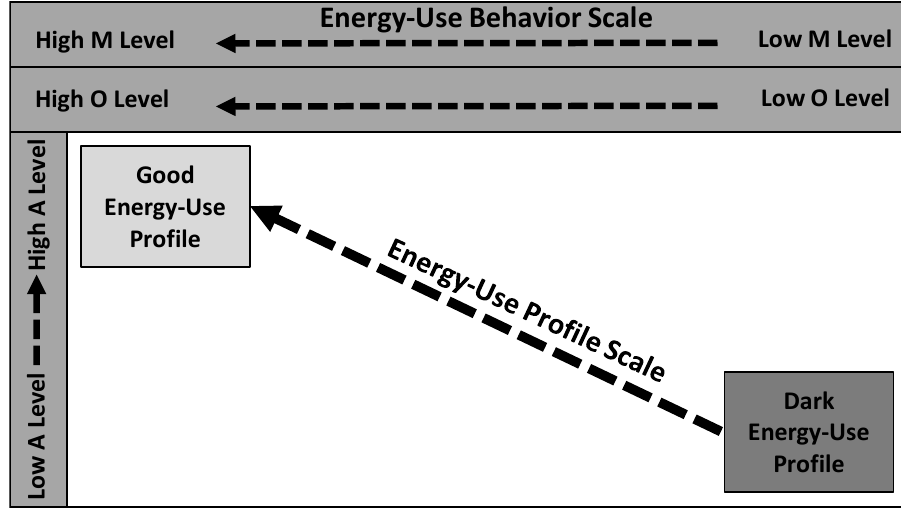
Figure 3. Template of Energy-Use Profile Matrix.